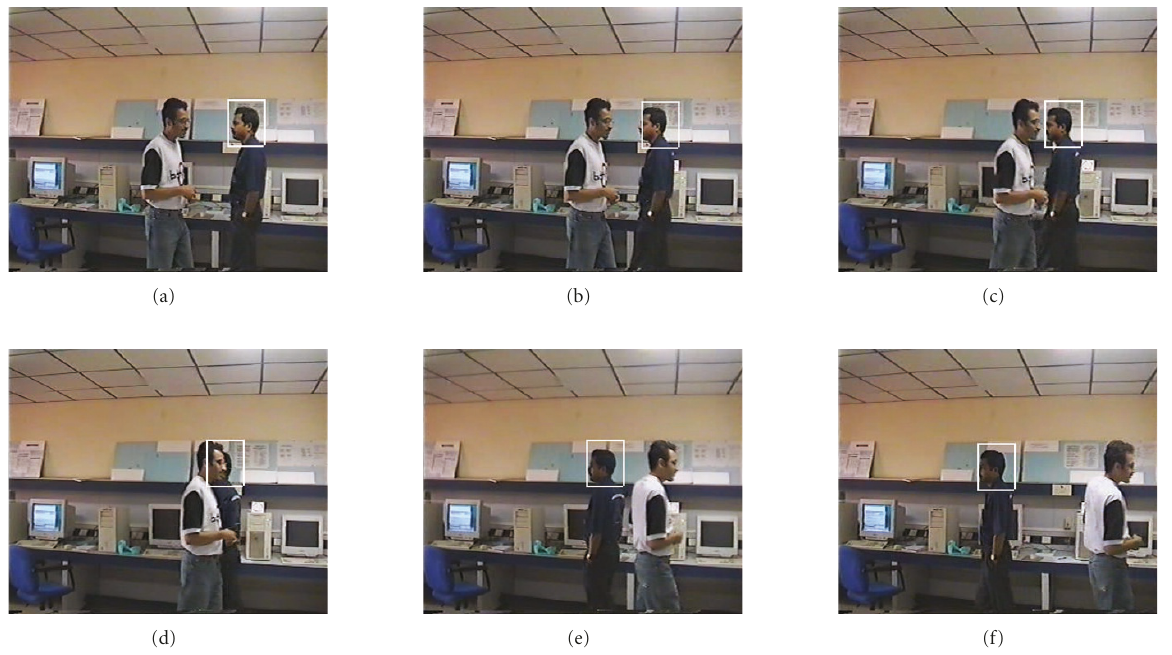
Figure 15: Hausdor ff distance-based tracking for two-men-walk sequence (a) at t = 3, (b) at t = 6, (c) at t = 10, (d) at t = 14, (e) at t = 25 (after occlusion), and (f) at t =